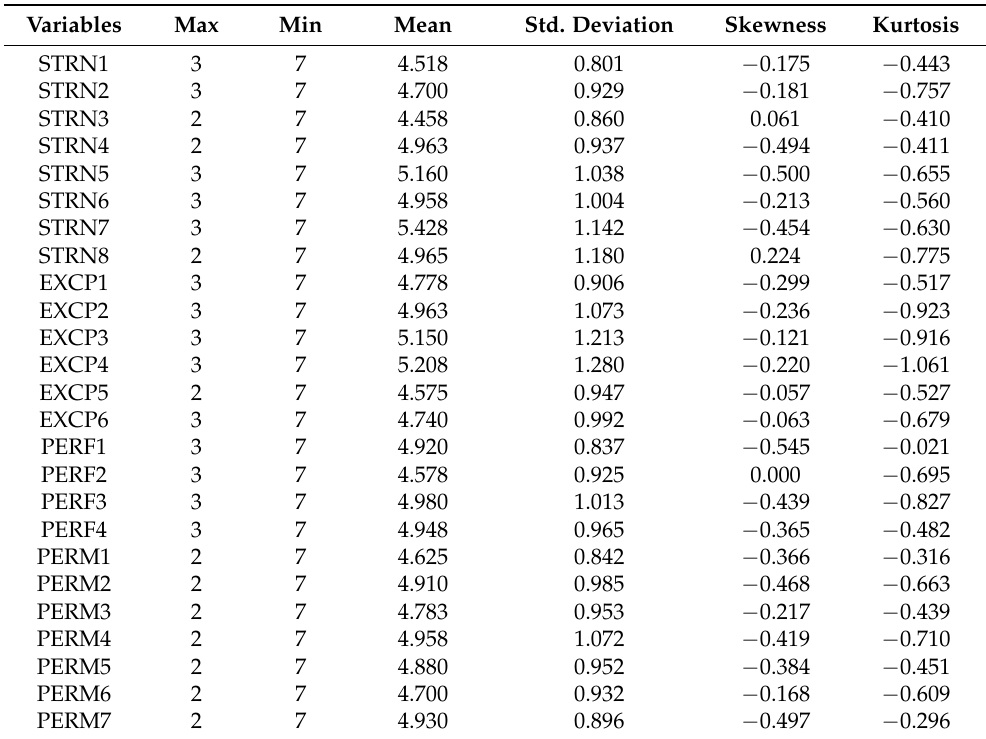
Table 2. Descriptive statistics for niche differentiation strategy, export promotion competitiveness, and export